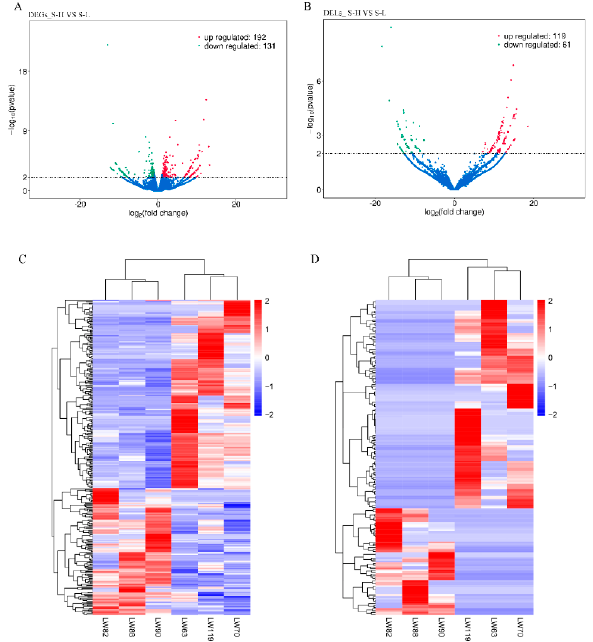
Figure 2. Comparative analysis of DEGs and DELs. ( A ) Volcano plot demonstrating a distinguishable DEGs expression pattern between S-H vs. S-L group. ( B ) Volcano plot demonstrating a distinguishable DELs expression pattern between S-H vs. S-L group. ( C ) Hierarchical clustering dendrogram analysis were conducted with DEGs among six different comparative groups. ( D ) Hierarchical clustering dendrogram analysis were conducted with DELs.